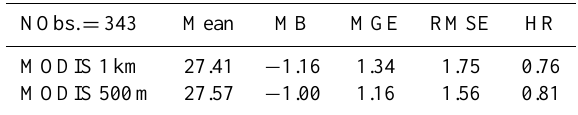
Table 1. Comparison of simulated temperatures using 500m and 1km MODIS land use data against the observations. Observed mean temperature is 28.58 ◦ C.